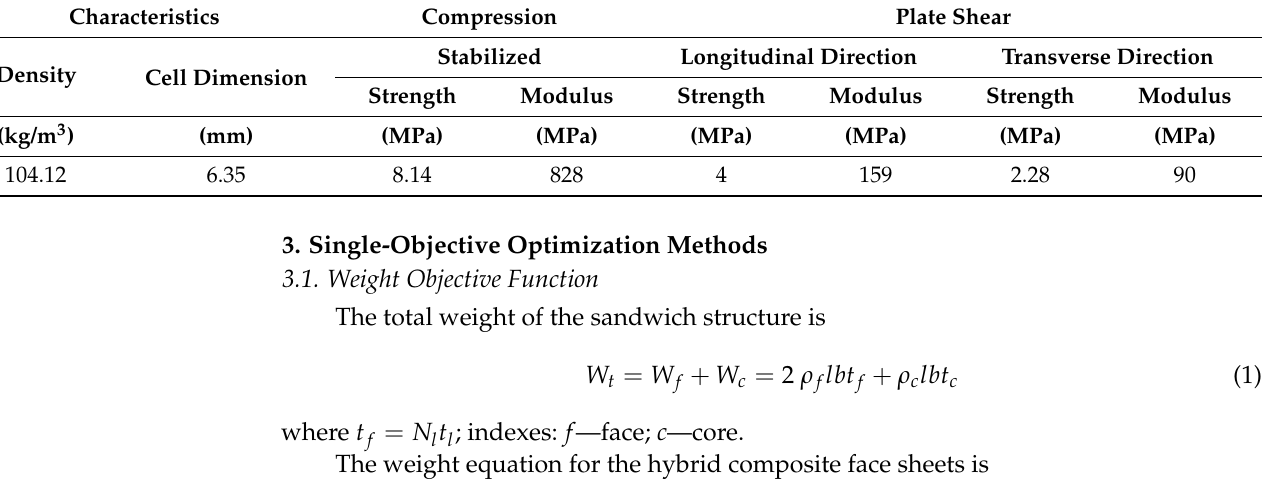
Table 4. Engineering properties for FRP honeycomb core [50].